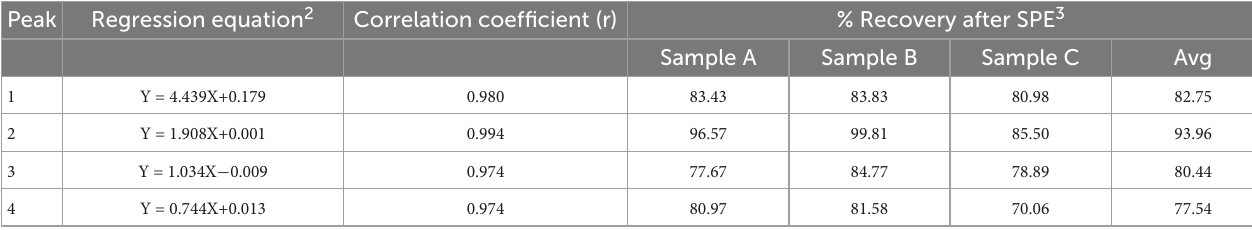
TABLE 3 Linearity of HPAEC-PAD 1 response for selected milk oligosaccharides and recovery after solid phase extraction (SPE). Peak Regression equation